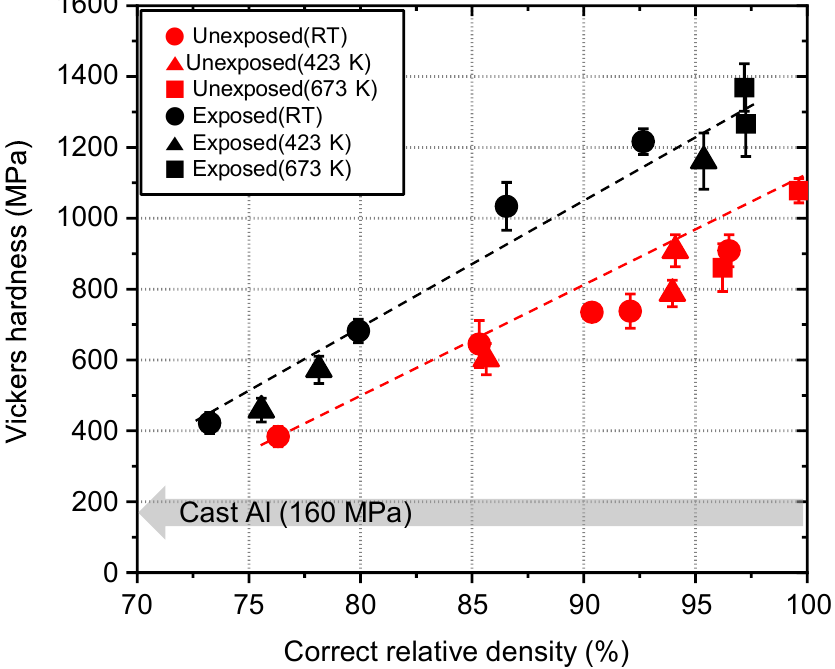
Figure 6. Vickers hardness of cold-compacted or sintered unexposed and exposed Al compacts as a function of correct relative density.